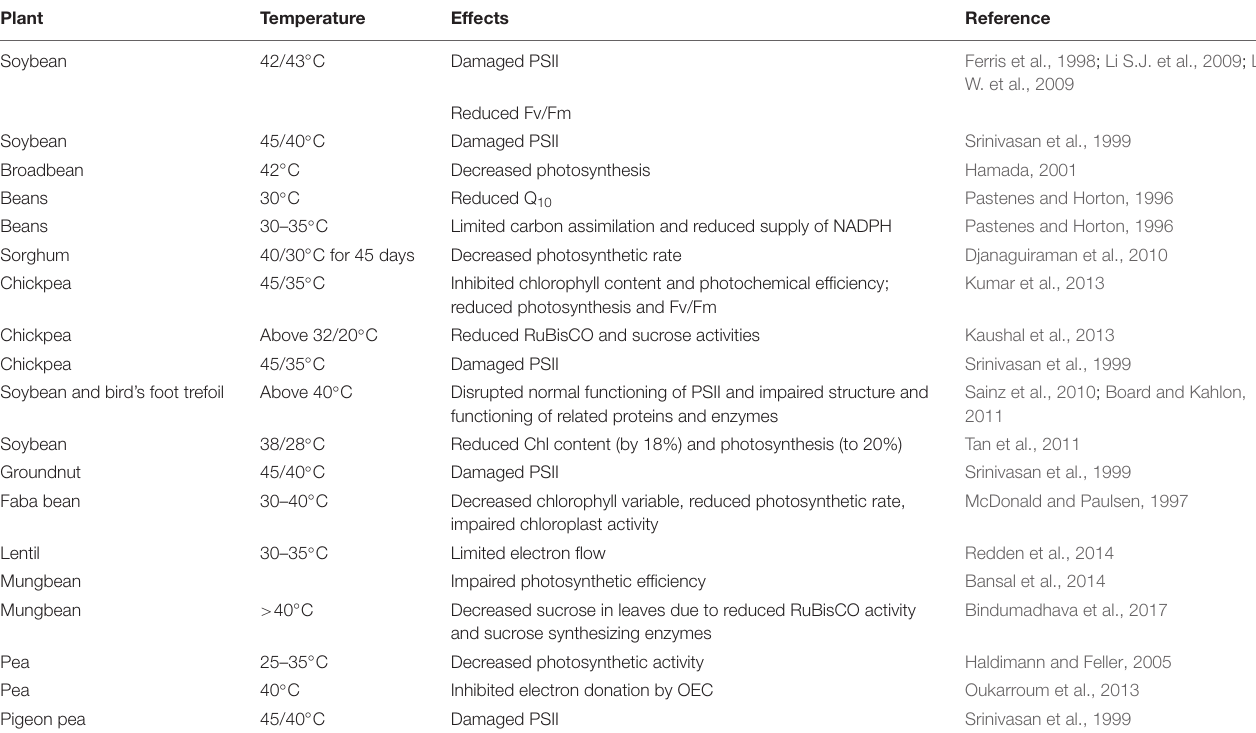
TABLE 4 | Effects of high temperature on the process of photosynthesis in some legume